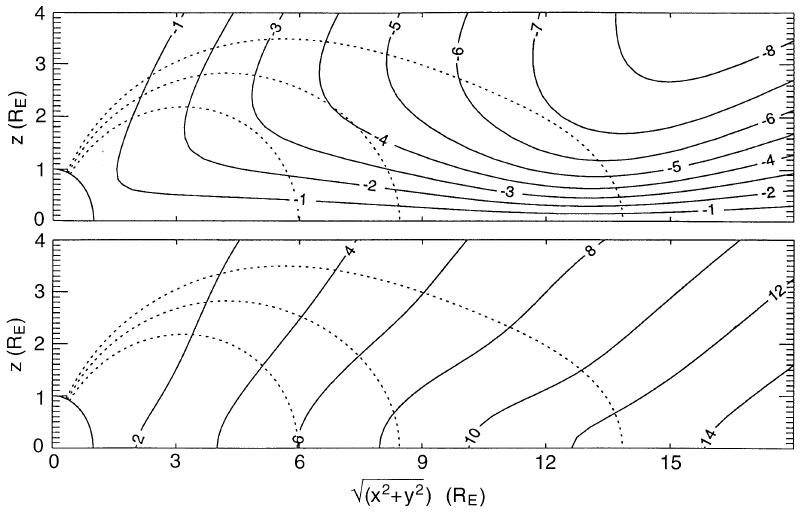
Fig. 4. The isolines of the intensity of the field-aligned ( top ) and perpendicular ( bottom ) components of the induced electric field in the 2100-MLT meridian plane at the moment of half-collapse ( t " t (cid:100) /2). The 65 ° , 68 ° , and 70 ° MLAT magnetic field lines are overplotted